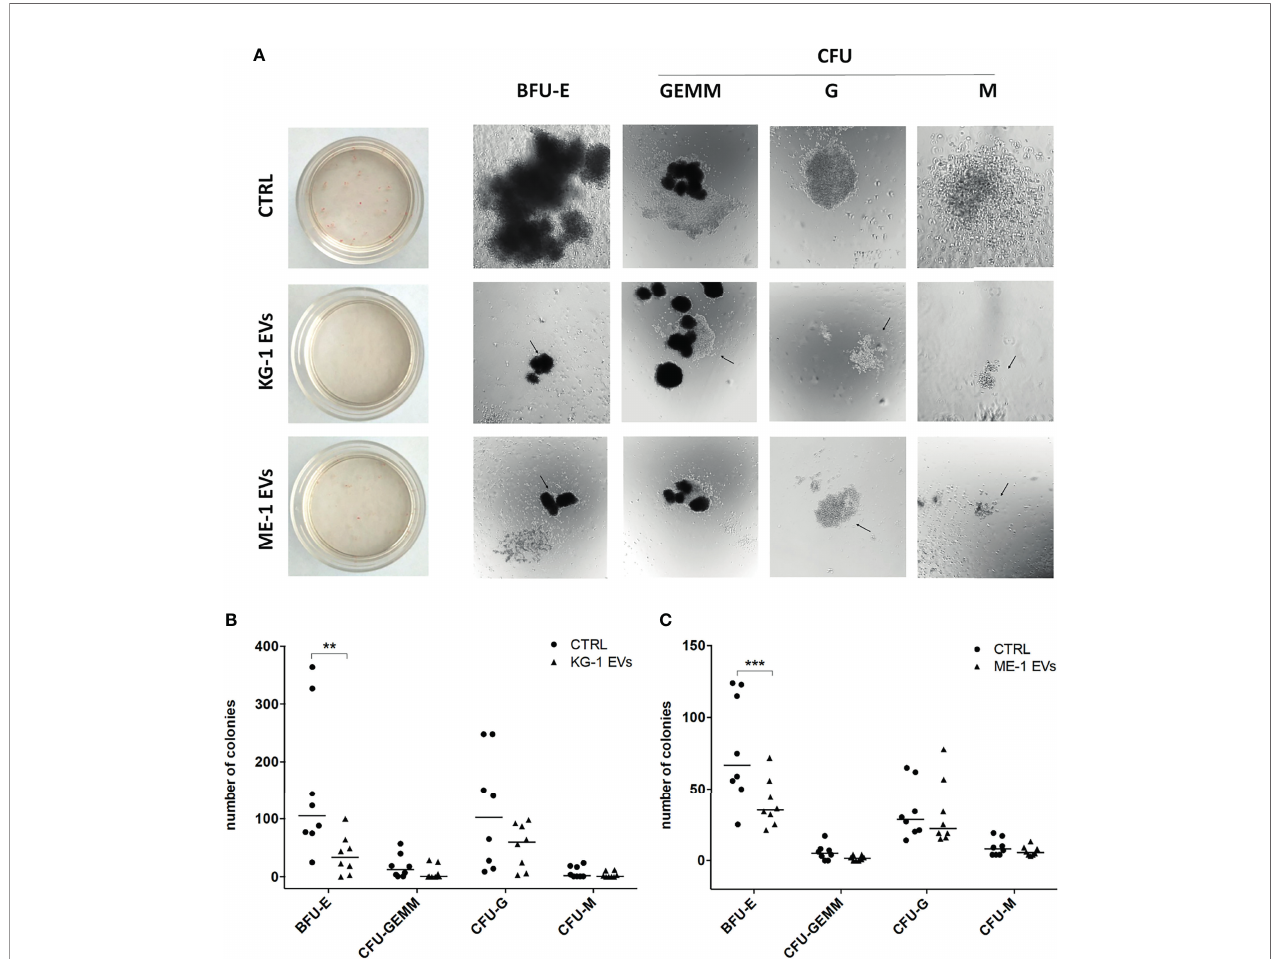
FIGURE 3 | AML-EV effects on HSPC colony formation. (A) Representative images of Burst-Forming-Unit Erythrocyte (BFU-E), colony forming unit (CFU)- Granulocyte, Erythrocyte, Macrophage, Megakaryocyte (CFU-GEMM), CFU Granulocyte (CFU-G) and CFU Macrophage (CFU-M) after 14 days of culture of HSPCs treated or not (CTRL) with KG-1 orME-1 derived-EVs. (B, C) Number of different colonies counted after 14 days of culture of HSPCs treated or not with AML-EVs. Each symbol represents a single experiment and horizontal bars represent median values. Statistically signi fi cant analyses are indicated by asterisks: **p < 0.01 and ***p <